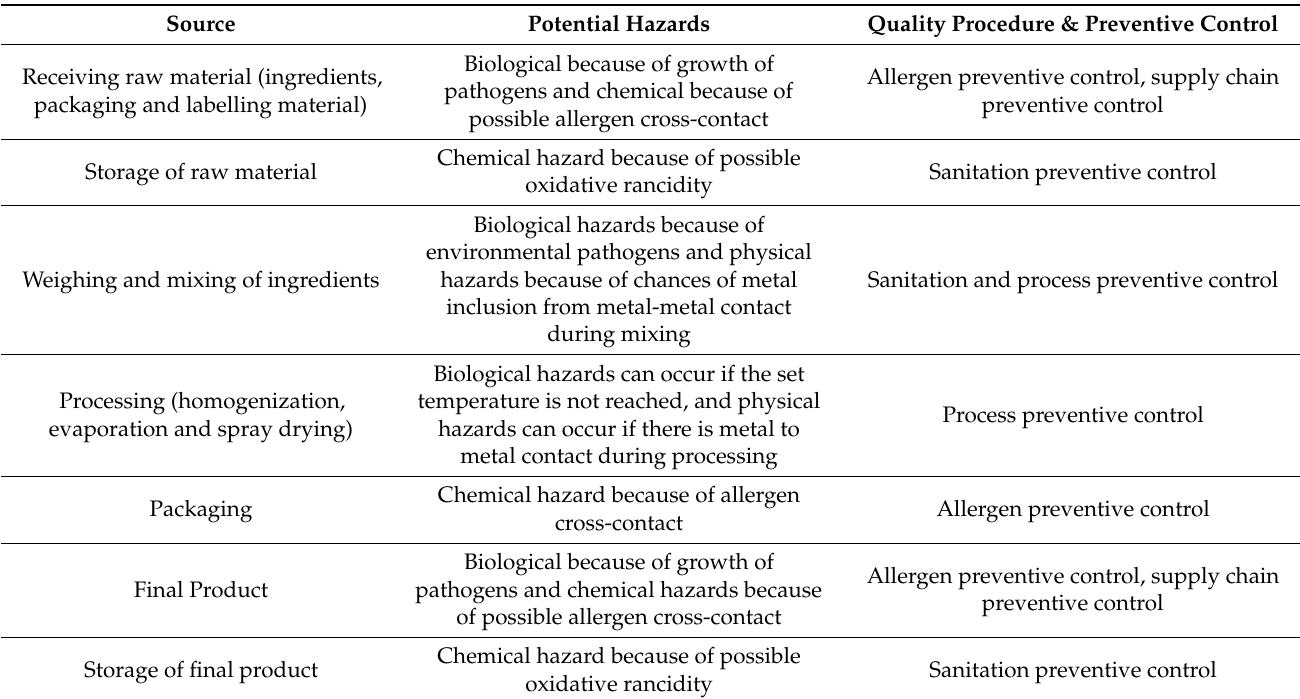
Table 7. Potential hazards associated with different processing steps of production of complementary